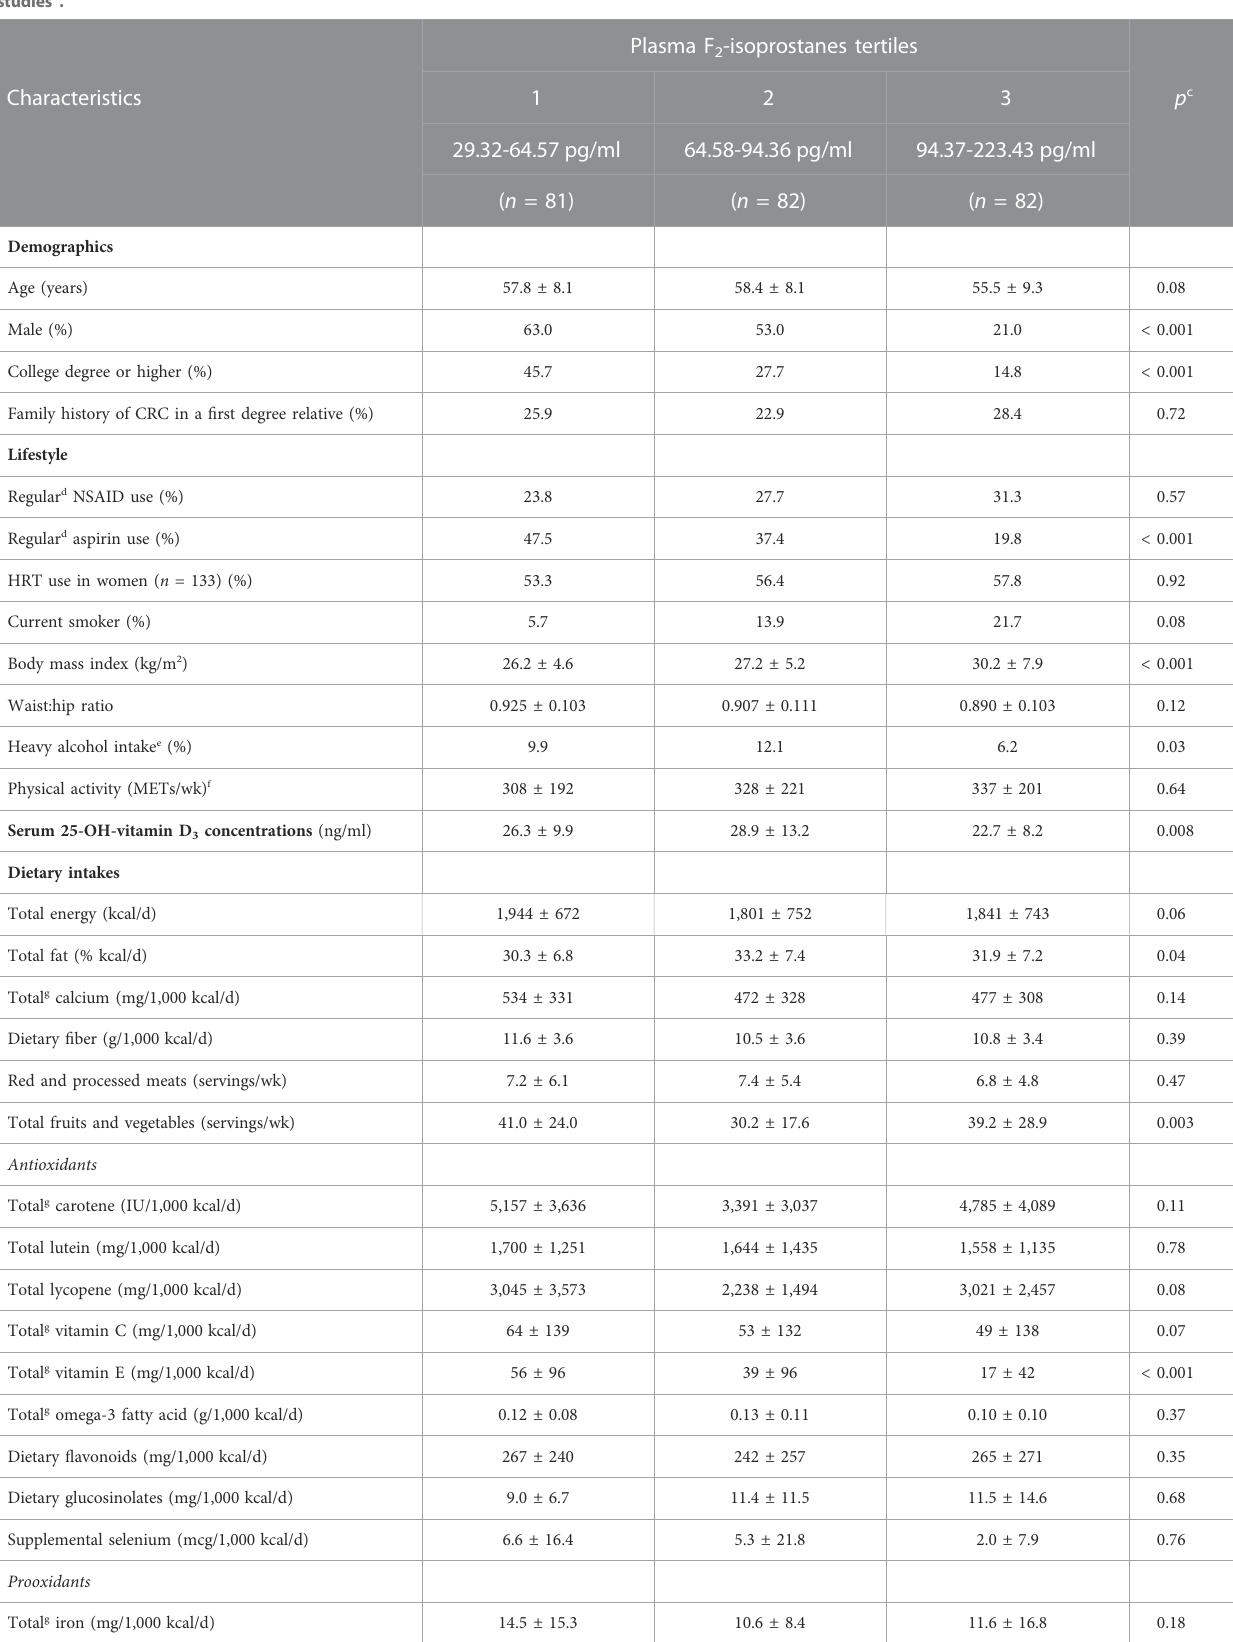
TABLE 1 Selected characteristics of participants ( n = 245) a , by tertiles of plasma F 2 -isoprostanes concentrations, in the pooled MAP I and MAP II cross-sectional studies b